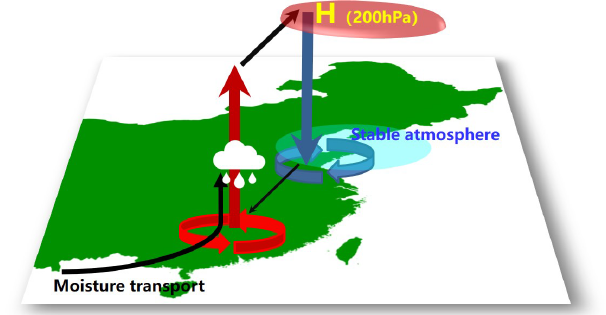
Figure 1. Schematic illustration of the local north–south circulation system. The circular red (blue) arrow indicates the anomalous cy- clone (anticyclone), the vertical red (blue) arrow indicates ascend- ing (descending) motion, the thick black arrow indicates northward movement in the upper-level troposphere, H indicates the anticy- clonic anomaly, and the white cloud indicates rainfall (see An et al., 2020, for caption